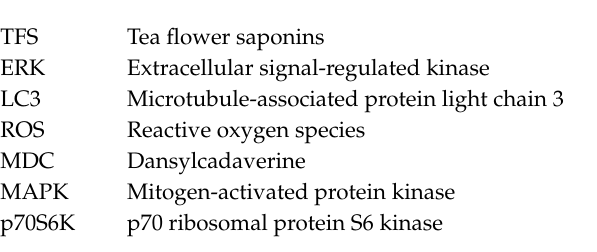
Figure S2: Saponins isolated from dried tea ( Camellia sinensis ) flowers, Figure S3: HPLC chromatograms of eluted fractions of 45%, 60%, 75%, 90% ethanol, Figure S4: Chromatograms of TFS 1, TFS 2and TFS 3 detected by LC /